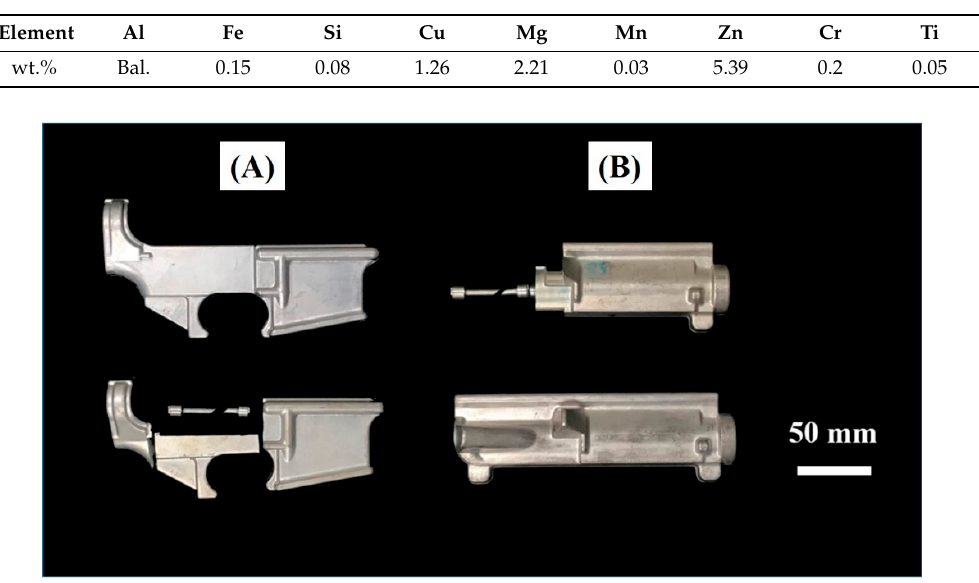
Table 1. Chemical composition (wt.%) of 7075 aluminum alloy.